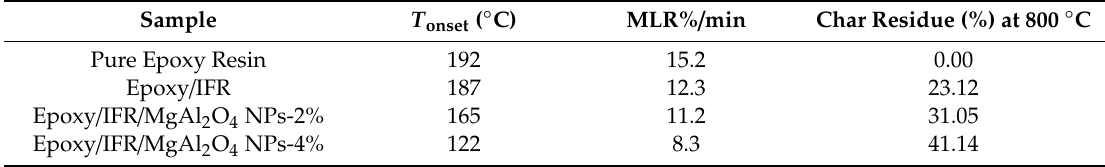
Table 3. Thermogravimetric results of the coatings under nitrogen atmosphere.